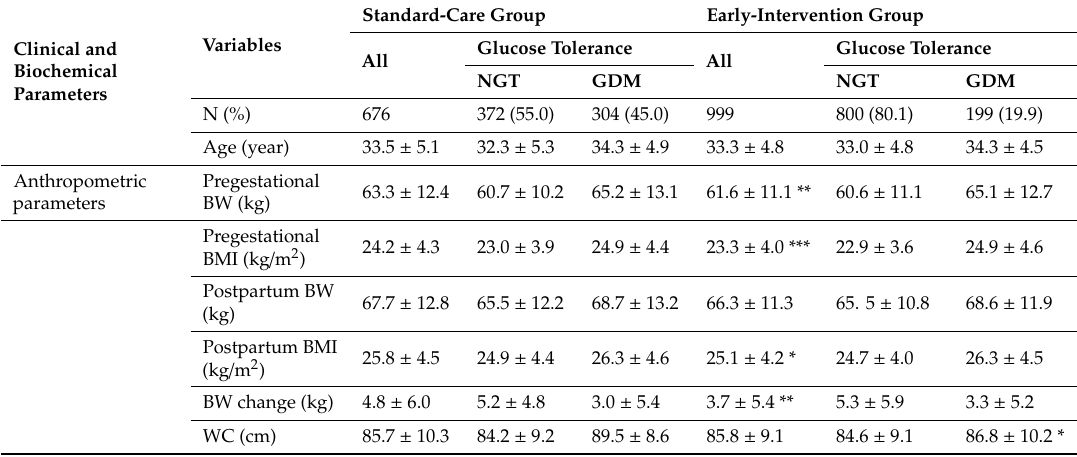
Table 3. Postpartum clinical and laboratory data by groups of intervention and subdivided by glucose